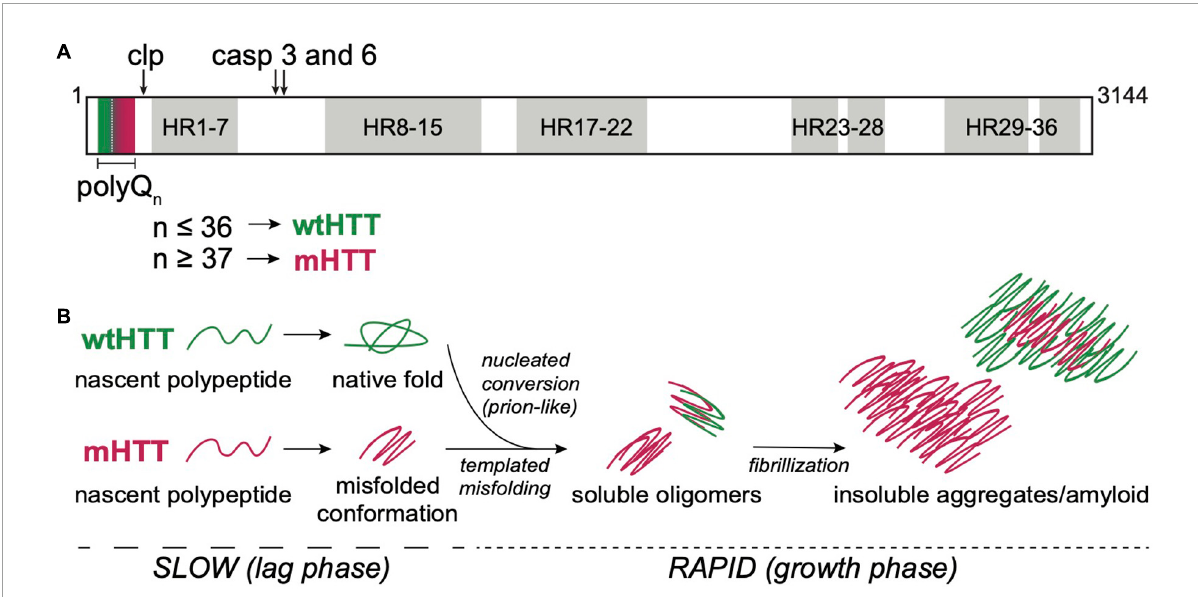
FIGURE1 HTT structure and aggregation mechanism. (A) Primary protein structure of full-length human HTT highlighting the N-terminal polyQ tract encoded by exon 1, calpain (clp) and caspase (casp) 3 and 6 cleavage sites, and 7 regions containing 36 HEAT repeat (HR). PolyQ tract lengths associated with wtHTT ( n ≤ 36) or mHTT ( n ≥ 37) proteins are indicated by green and red, respectively, in and below the protein structure. (B) mHTT aggregation occurs via nucleated growth polymerization. wtHTT proteins achieve their native, functional fold, whereas expanded polyQ tracts cause mHTT proteins to misfold and a stabilize once a critical nucleus is achieved. This rate-limiting step is followed by rapid addition of mHTT monomers via templated misfolding to form soluble oligomers and, ultimately, insoluble, β -sheet-rich, amyloid fibrils. Prion-like conversion of wtHTT also occurs via templated conformational stabilization of natively-folded wtHTT proteins by mHTT aggregate